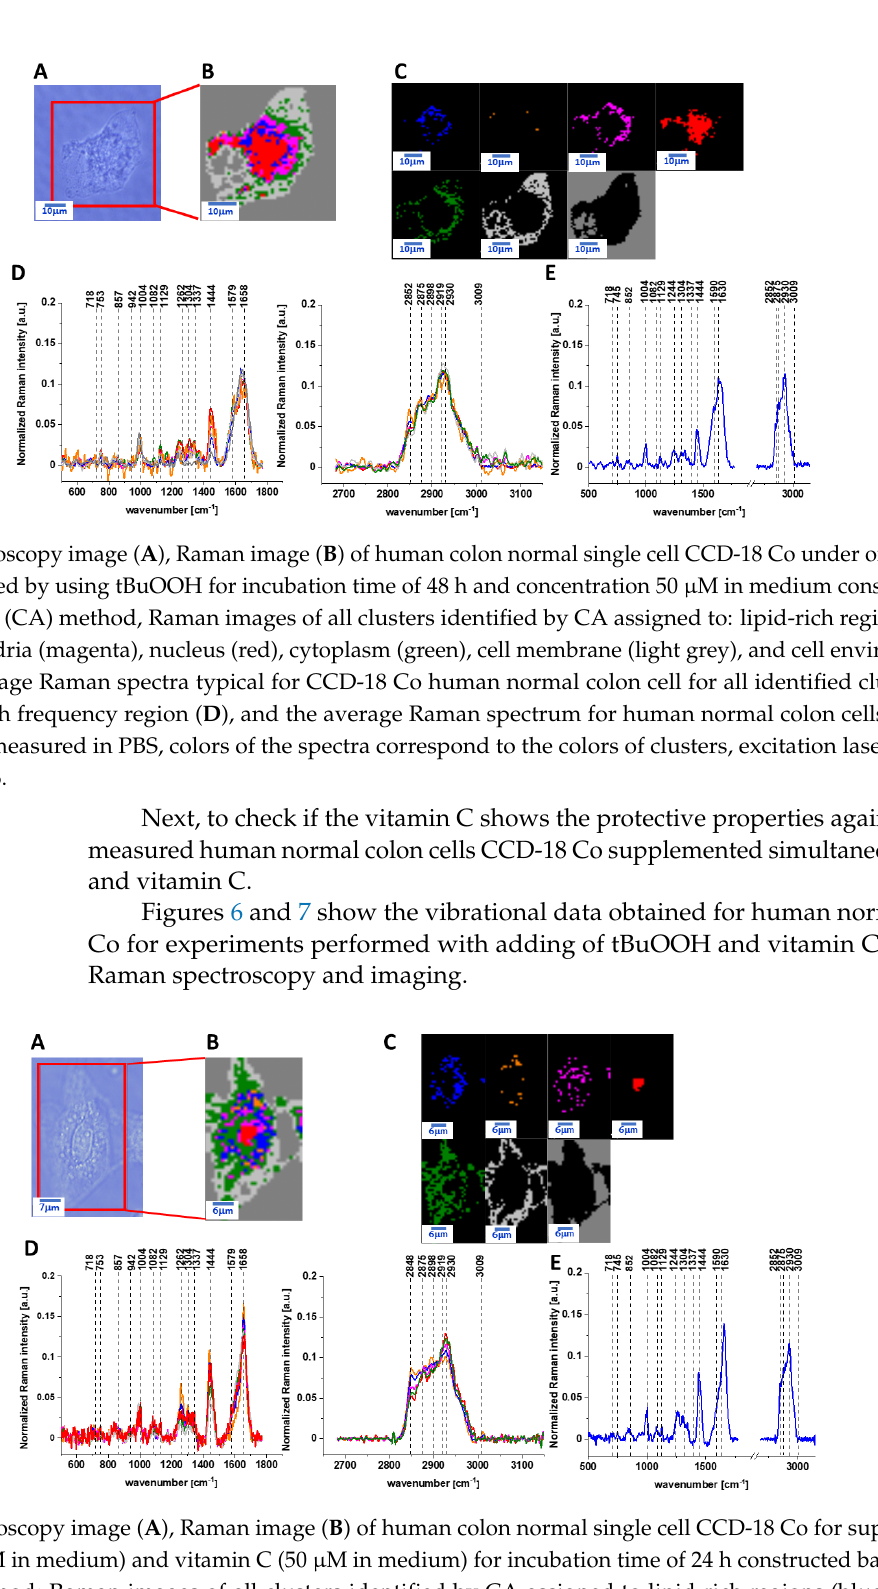
Figure 4. The microscopy image ( A ), Raman image ( B ) of human colon normal single cell CCD-18 Co under oxidative stress conditions generated by using tBuOOH for incubation time of 24 h and concentration of 50 µM in medium con- structed based on cluster analysis (CA) method; Raman images of all clusters identified by CA assigned to lipid-rich re- gions (blue and orange), mitochondria (magenta), nucleus (red), cytoplasm (green), cell membrane (light grey), and cell environment (dark grey) ( C ); the average Raman spectra typical for CCD-18 Co human normal colon cell for all identified clusters for low frequency and high frequency region ( D ), and the average Raman spectrum for human normal colon cells - for cells as a whole ( E ), cells measured in PBS, colors of the spectra correspond to the colors of clusters; excitation laser line 532 nm; number of cells=6.